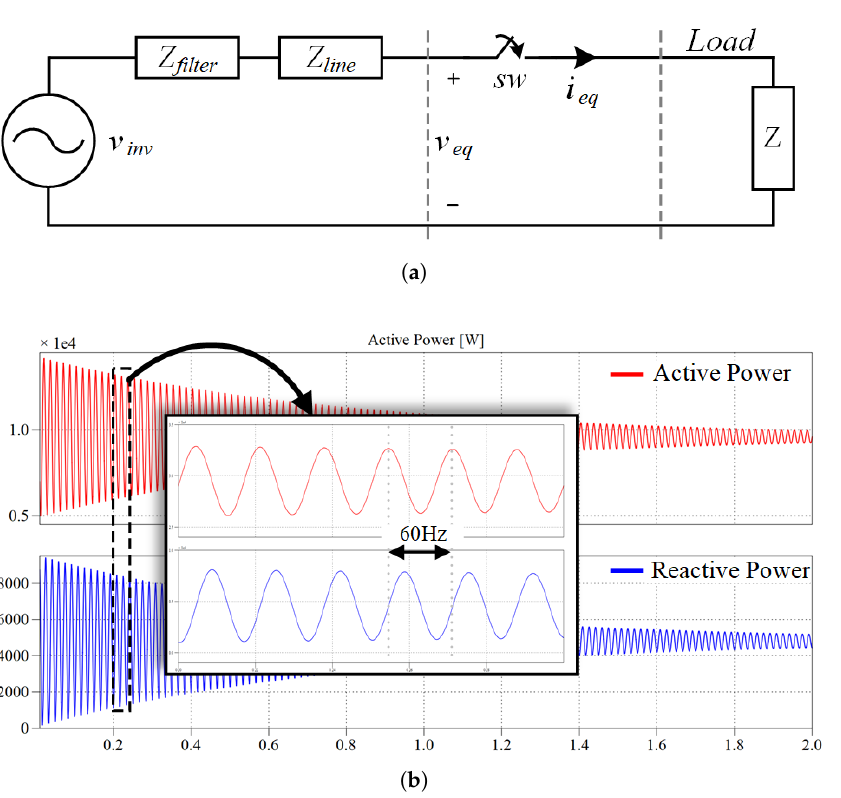
Figure 4. ( a ) Simplified synchronverter system circuit diagram and ( b ) power oscillation occurred in islanded power system during load